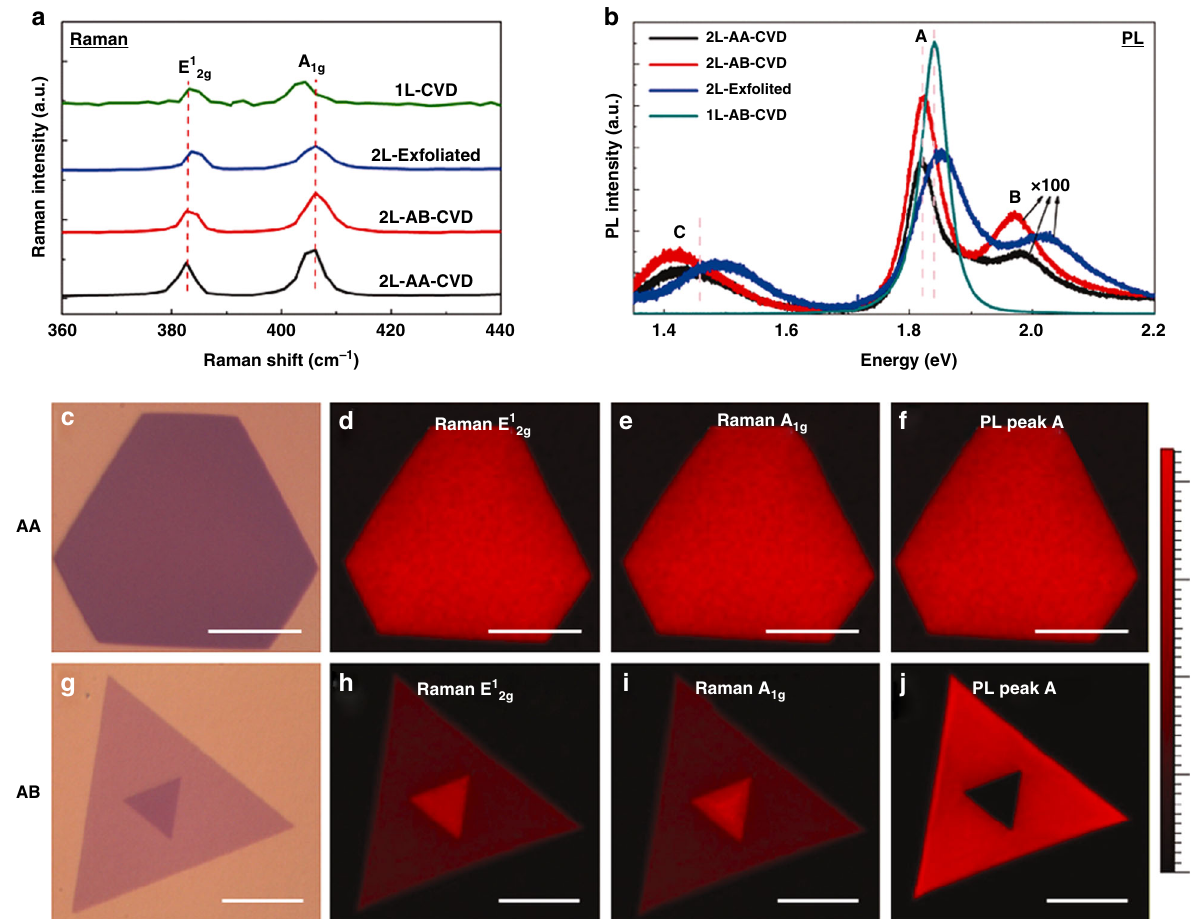
Fig. 3 Raman and PL studies of the bilayer MoS 2 crystals. a Raman and b PL spectra of the as-grown AA and AB stacking bilayer MoS 2 , CVD-grown monolayer MoS 2 and mechanically exfoliated bilayer MoS 2 , where the PL signal of all bilayer samples were enlarged by 100 times in order to compare with that of monolayer one. Optical image ( c ) the Raman peak intensity mappings of E 1 2g ( d ) and A 1g ( e ) as well as the PL intensity mapping of peak A ( f ) of the as-grown complete AA stacking bilayer MoS 2 . g Optical image, the Raman peak intensity mappings of E 1 2g h and A 1g i as well as the PL intensity mapping of peak A j of the as-grown AB stacking bilayer MoS 2 . The scale bar is 50 μ